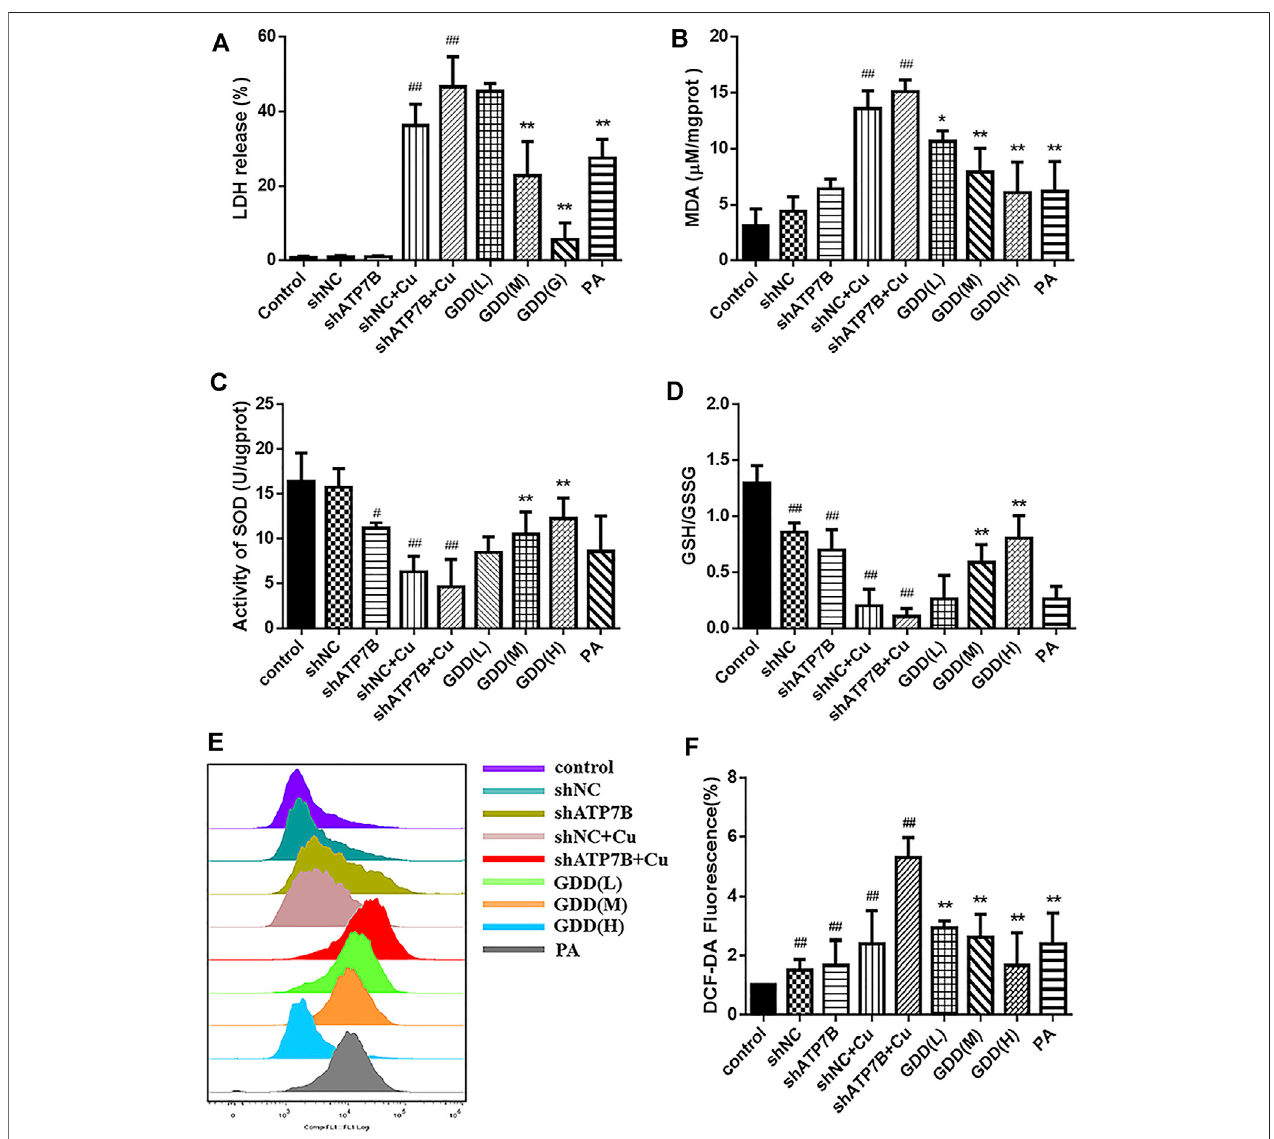
FIGURE4| Effects ofMDA (A) ,LDH release (B) , SOD (C) , GSH/GSSG (D) , and ROS (E, F) levels incopper-ladenHLD hepatocytes ( (cid:1) x ± s , n (cid:1) 3). # p < 0.05, ## p < 0.01 compared with control group; * p < 0.05, ** p < 0.01 compared with shATP7B + Cu group.